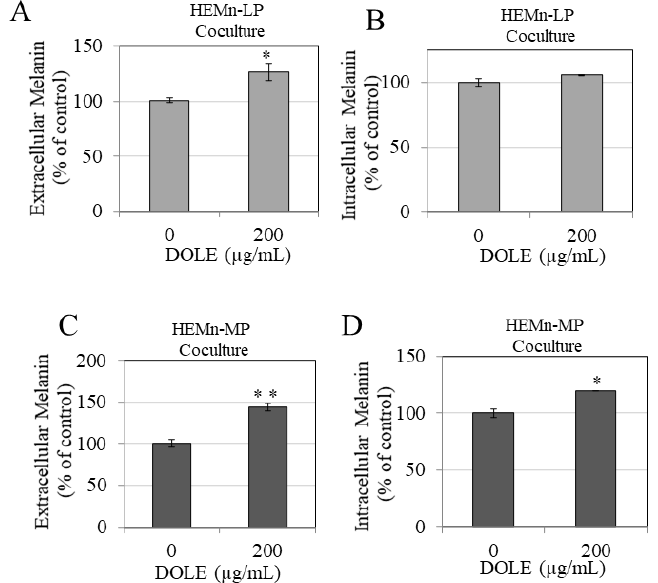
Figure 5. ( A ) Extracellular melanin and ( B ) intracellular melanin levels in cocultures of HEMn-LP cells treated in the absence or presence of 200 µg/mL DOLE; ( C ) extracellular melanin and ( D ) intracellular melanin levels in cocultures of HEMn-MP cells treated in the absence or presence of 200 µg/mL DOLE; all data are mean ± SEM of triplicates; * p < 0.05 and ** p < 0.01 vs. control unpaired student’s t -test.